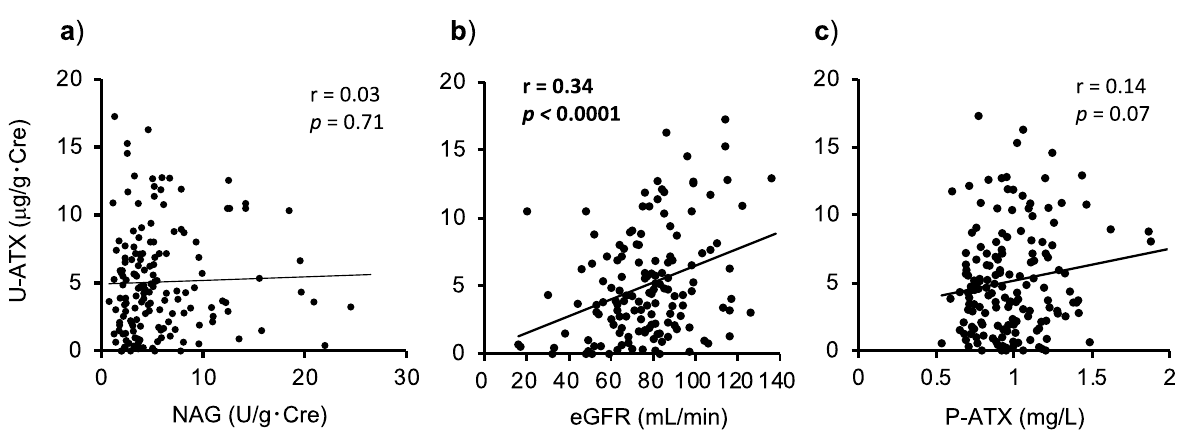
Figure 3. Comparison of the values of the U-ATX levels in relation to the those of the urine NAG, eGFR and P-ATX. Correlations between the values of the U-ATX levels and urine NAG ( a ), eGFR ( b ) and P-ATX ( c ). Data were statistically analyzed by the Spearman’s rank test. Bold denotes values p <